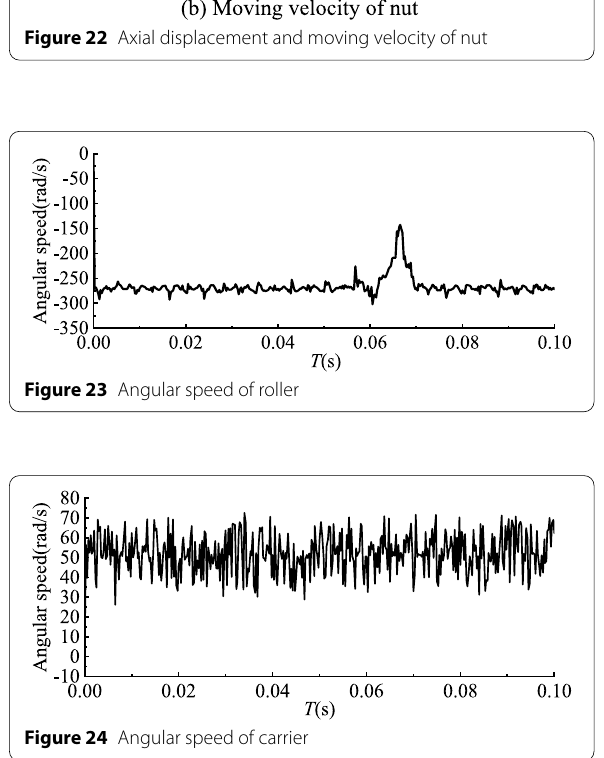
Figure 21 Displacement of roller